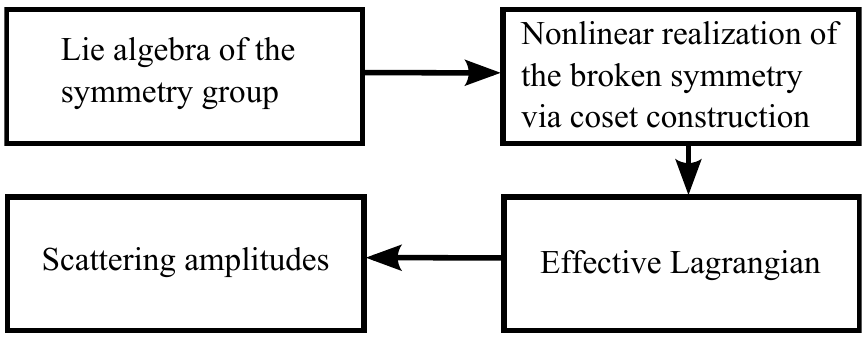
Figure 1 . The basic scheme of construction of the scattering amplitudes for NG bosons of spon- taneously broken symmetry. The scattering amplitudes are fully determined by symmetry except for a few low-energy coupling constants. The latter can in turn be traded for any physical observ- ables, invariant under the reparametrization of the coset space, for instance the values of selected scattering amplitudes at a (cid:12)xed kinematical